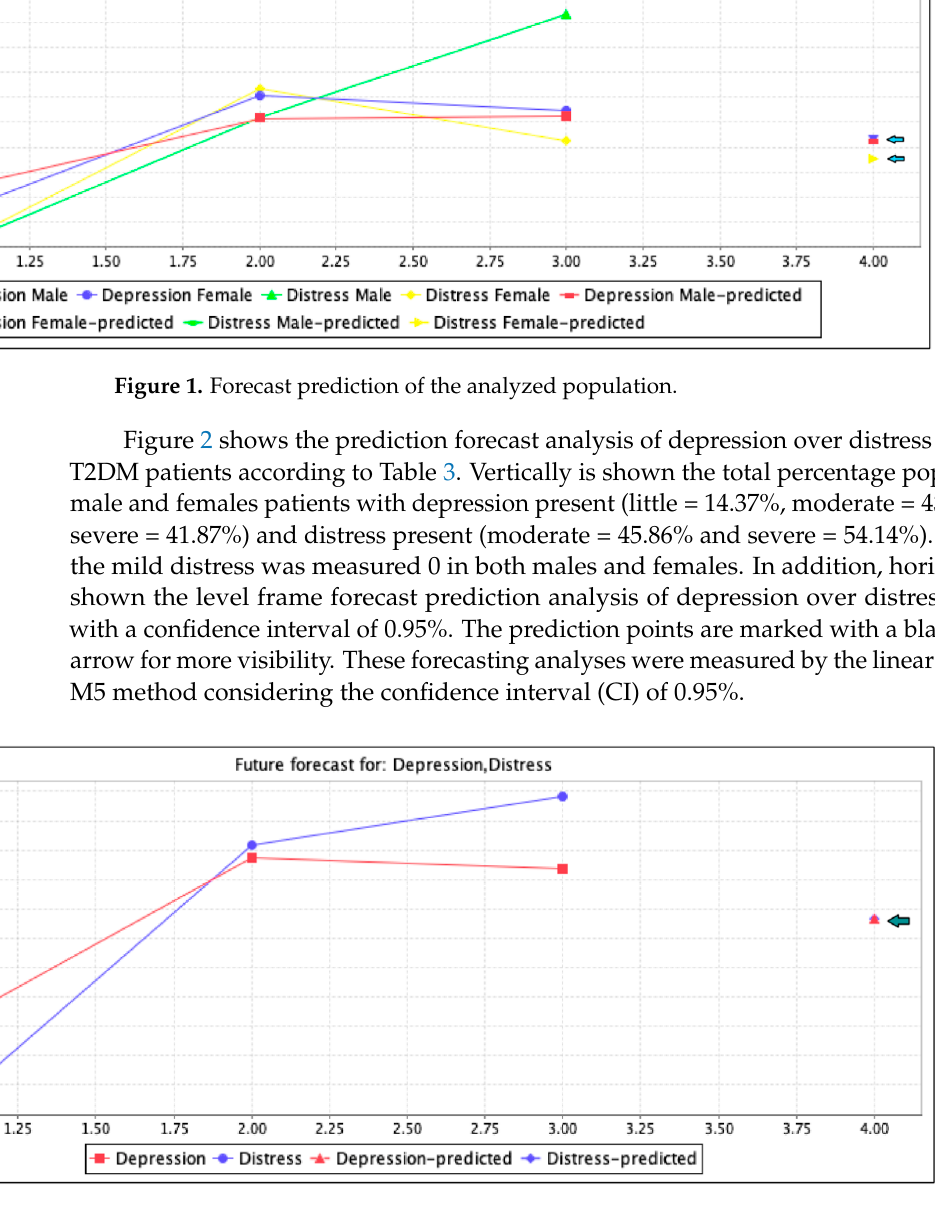
Figure 2. Forecast analysis of depression over distress.